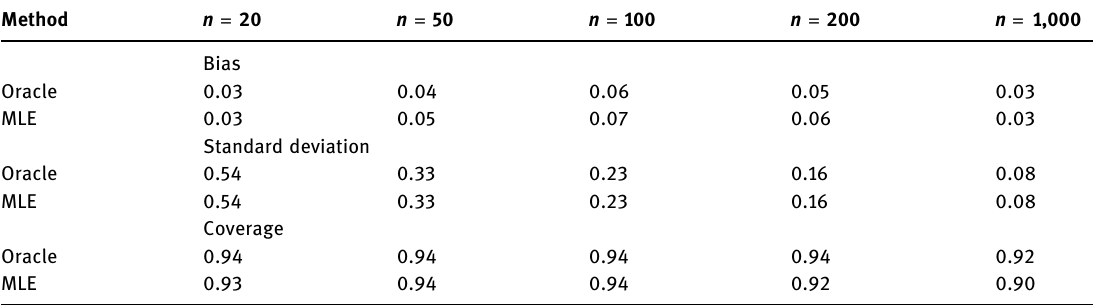
Table A2: Results of simulation scenario 2S comparing oracle GBCEE to MLE GBCEE